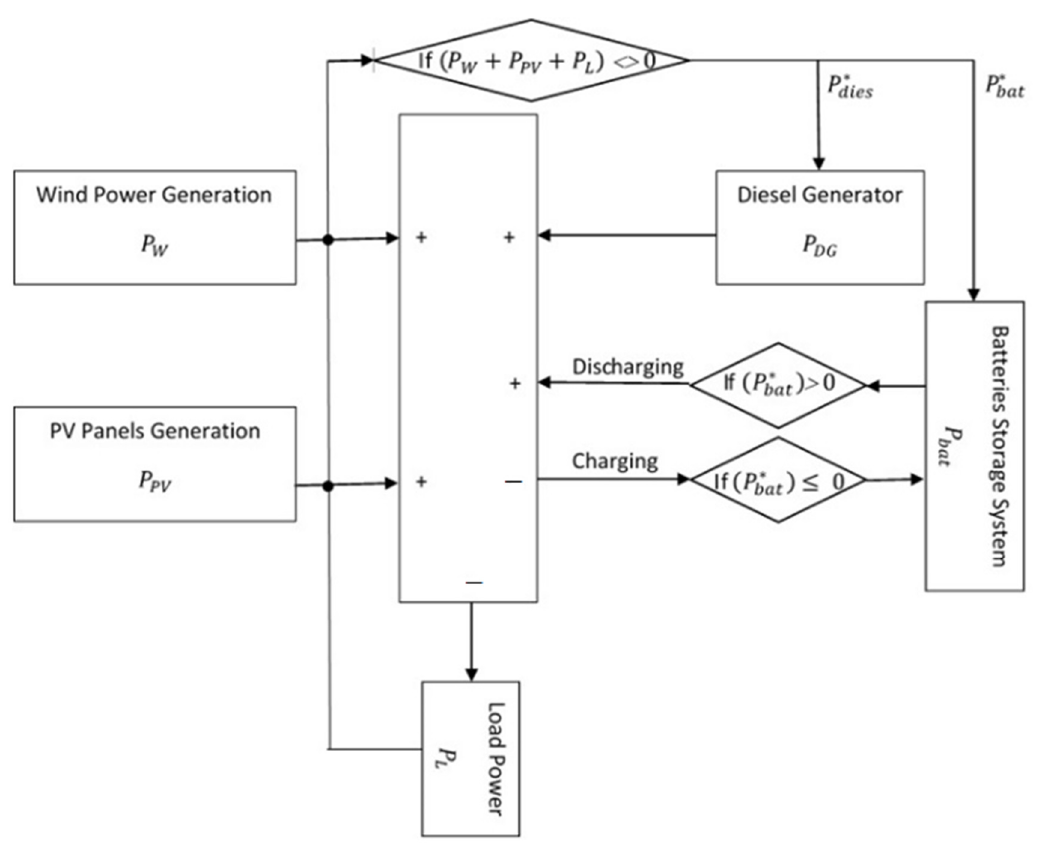
Figure 10. Management scheme for load sharing.